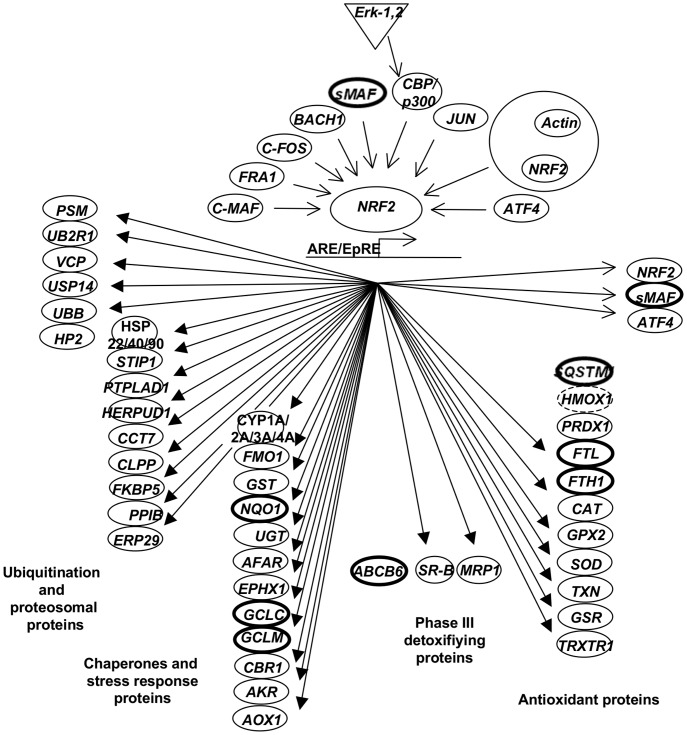
The Nrf2-Keap1 regulatory pathway and iAs responsive transcripts.Known and novel iAs responsive Nrf2 transcripts are shown. Empty circles depict unaffected target transcripts (not differentially expressed in lymphoblastoid cells). Bold and no continuous line circles indicate the level of increased gene expression as identified within this study. Bold line = 2–5 fold, no continuous line = >10. Bold letter depicted novel Nrf2-target genes identify by microarrays.